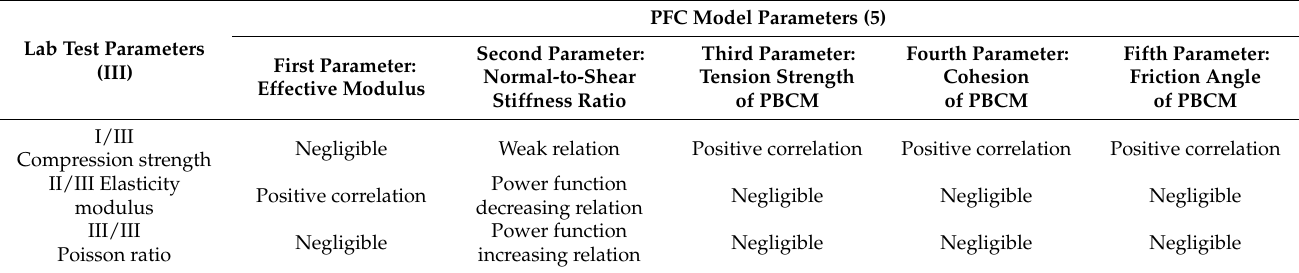
Table 1. Parameter calibration law of the PFC